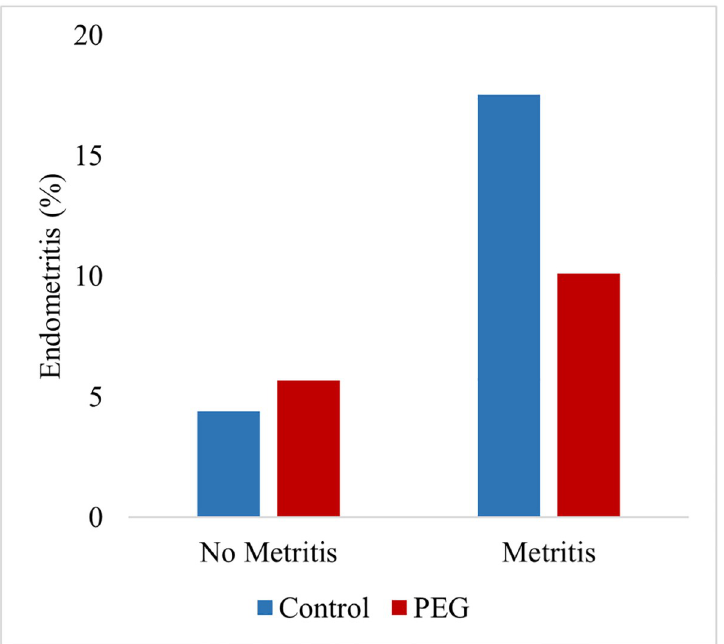
Fig 4. Cows with a diagnosis of endometritis (%) by previous metritis diagnosis. No metritis: Control = 837, PEG = 778; Metritis: Control = 177, PEG = 177. There was a significant interaction between treatment and the previous occurrence of metritis P =